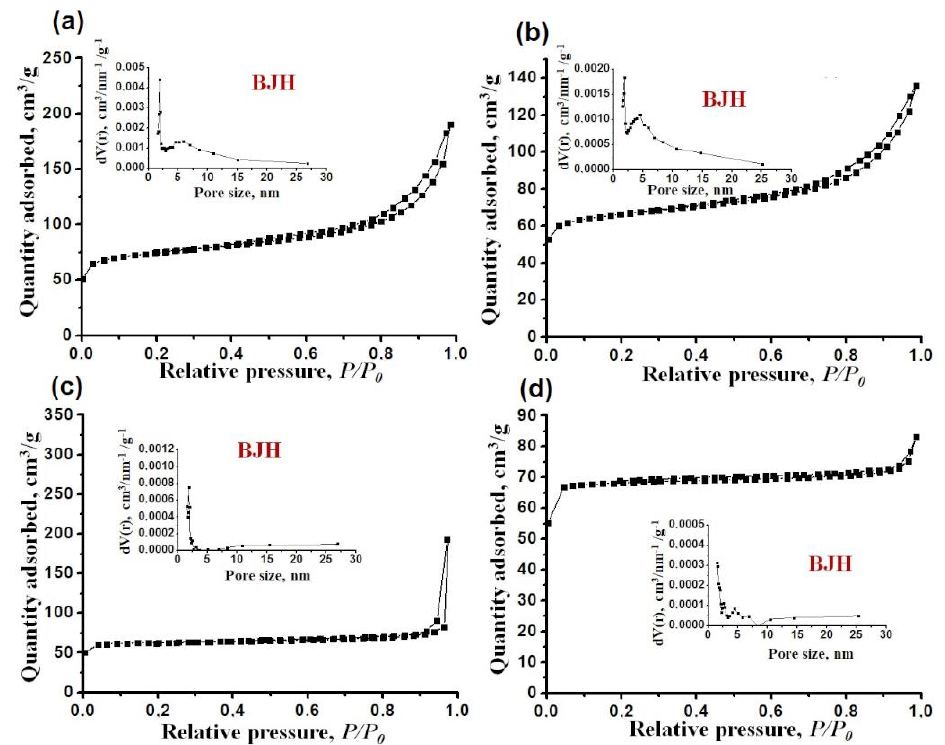
Figure 7. Nitrogen adsorption–desorption isotherms and pore size distribution of molecular sieves: ( a ) Sample IF-iAl-90; ( b ) Sample IF-iAl-130; ( c ) Sample IF-SB-90; ( d ) Sample